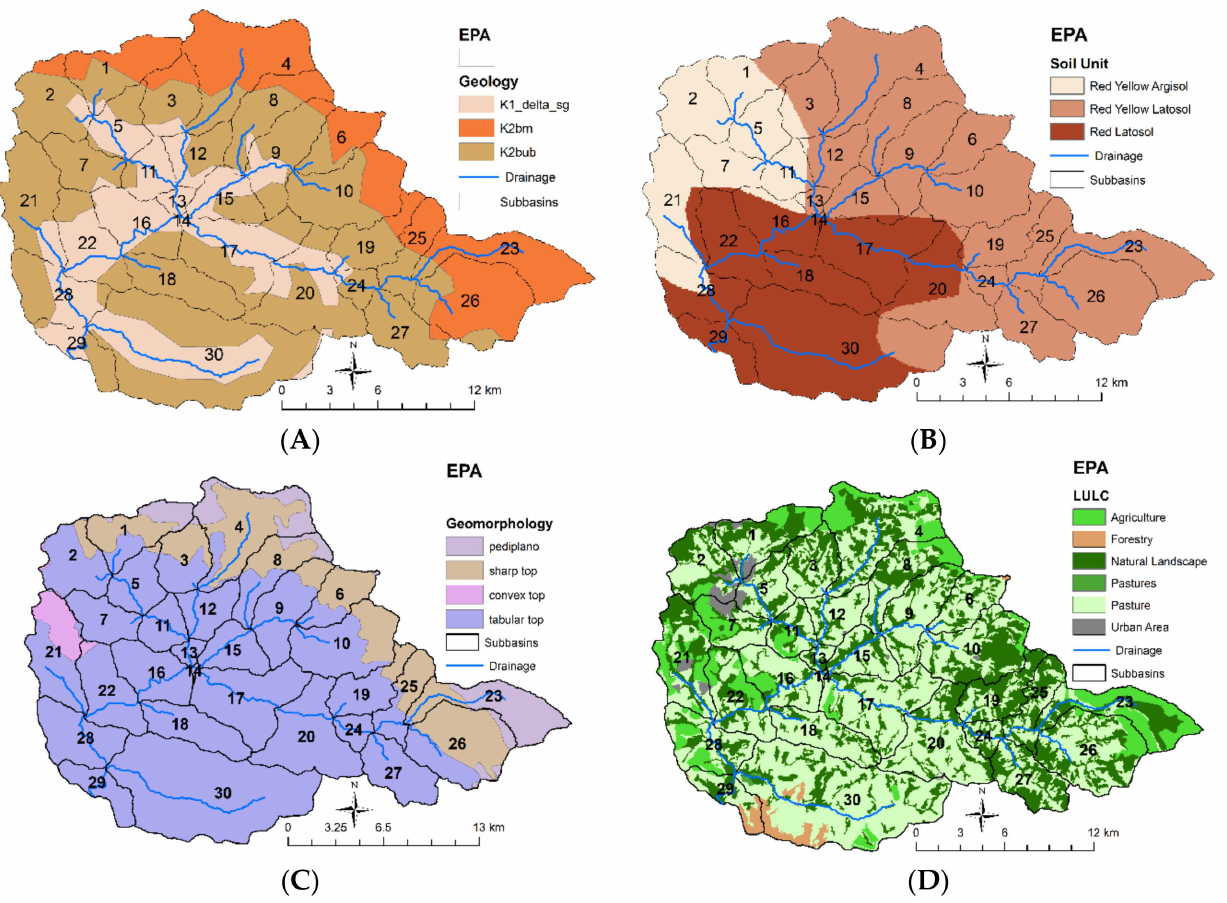
Figure 3. Geology ( A ), soil ( B ), geomorphology ( C ), and land use ( D ) at the EPA of Uberaba River. Source ( A ): The author, adapted from